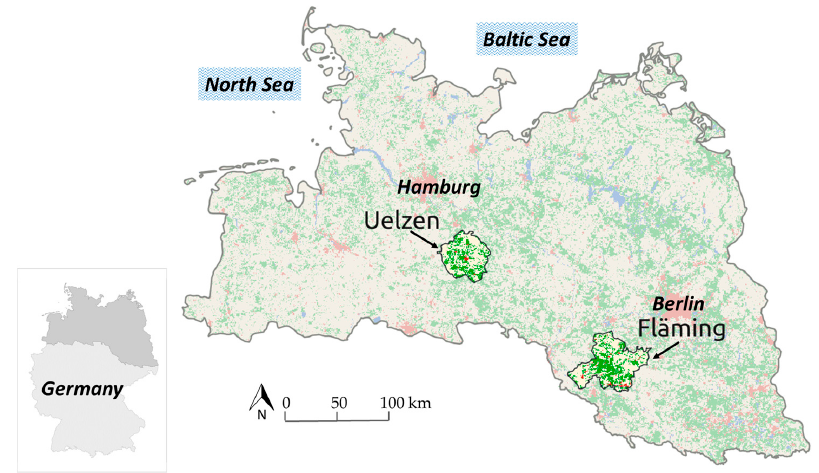
Figure 1. The two study regions Uelzen and Fläming in the North German Plain near the cities of Hamburg and Berlin (land cover data in the overview map © ESA/ESA GlobCorine Project, led by Université Catholique de Louvain).